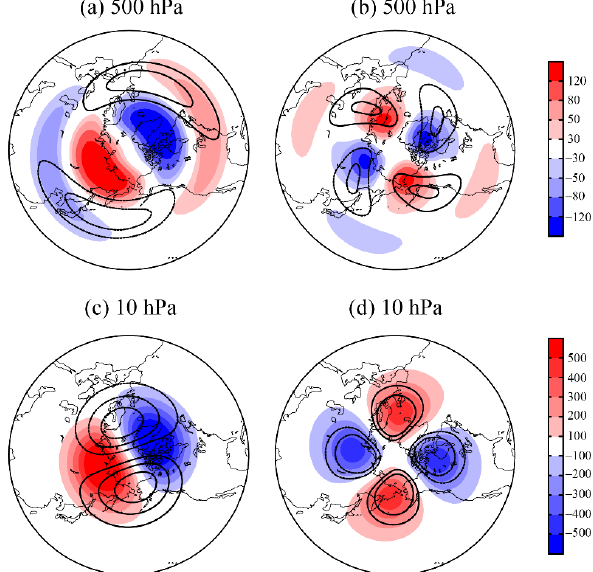
Figure 9. The ( a , c ) wavenumber-1 and ( b , d ) wavenumber-2 components of geopotential height anomalies (shadeding, unit: gpm) at ( a , b ) 500 hPa and ( c , d ) 10 hPa averaged over 10 days (1–10 February) before the 2018 SSW onset. Contours are climatological wavenumber-1 and wavenumber-2 components in the corresponding period. The contour levels are successively ± 200, ± 400, and ± 600 gpm in ( c ) and ± 60, ± 90 gpm in ( a , b , d ),